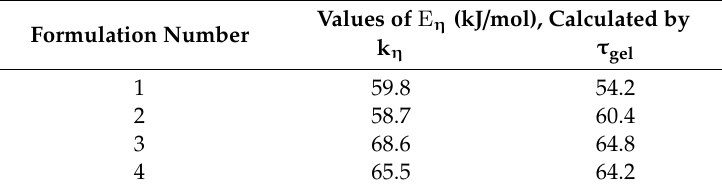
Table 4. Values of activation energies ( Е η ) for systems 1–4, calculated by the viscosity increase rate constantand by the time of